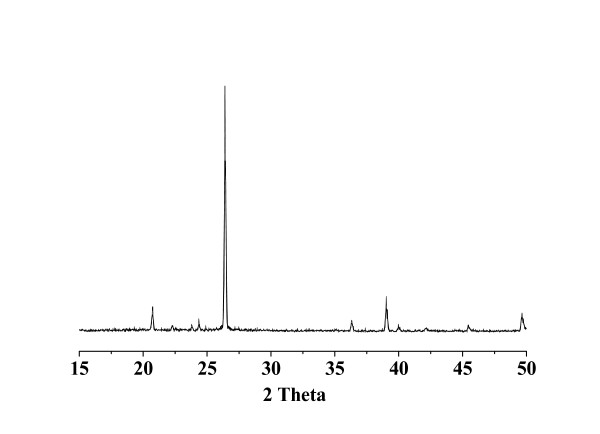
The XRD pattern for ZnAlPO4.